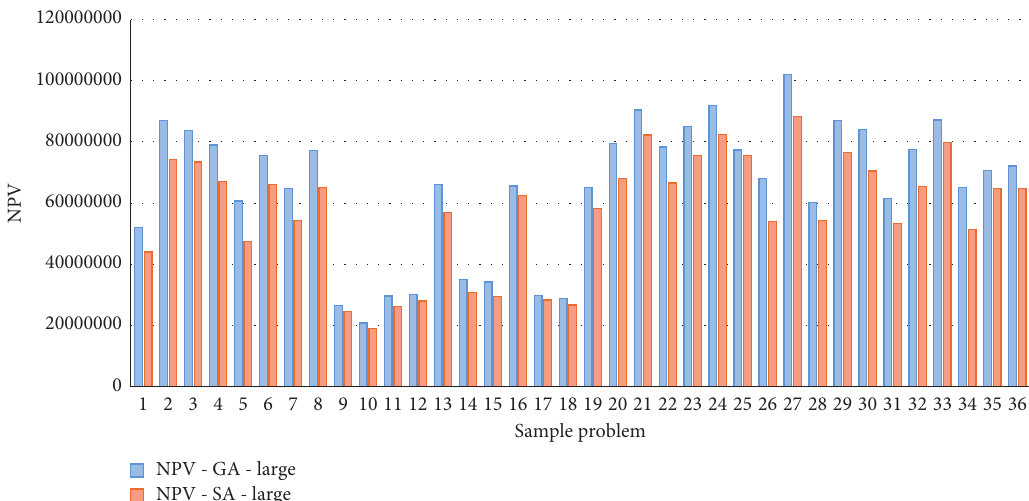
Figure 5: Comparison chart of net present value obtained by GA and SA algorithms in large